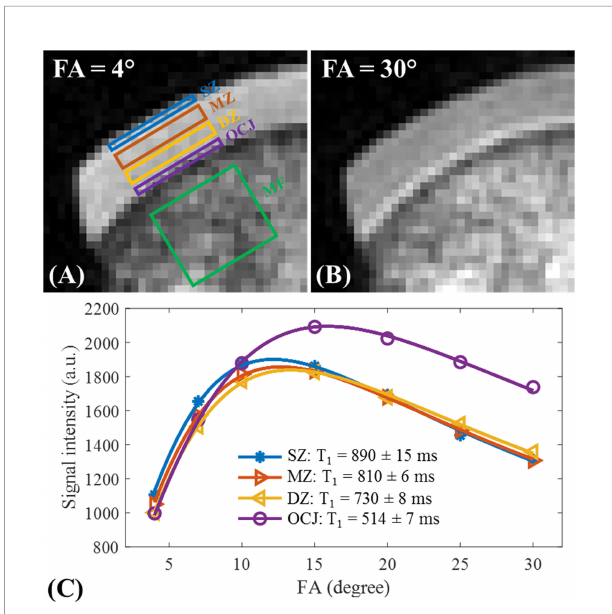
FIGURE 8 | T 1 measurements of a sample of patellar cartilage in the super fi cial zone (SZ), middle zone (MZ), deep zone (DZ), and OCJ region. The bone marrow fat (MF) section has also been labeled in (A) Images with respective fl ip angles of 4° and 30° are demonstrated in (A, B) In the image with the fl ip angle of 30°, a high signal intensity band can be seen in the OCJ region. Image (C) demonstrates the fi tting curves and T1 values for the SZ, MZ, DZ, and OCJ. Gradual decrease of T1 values from SZ to OCJ is observed. Modi fi ed, with permission from Ref (28).